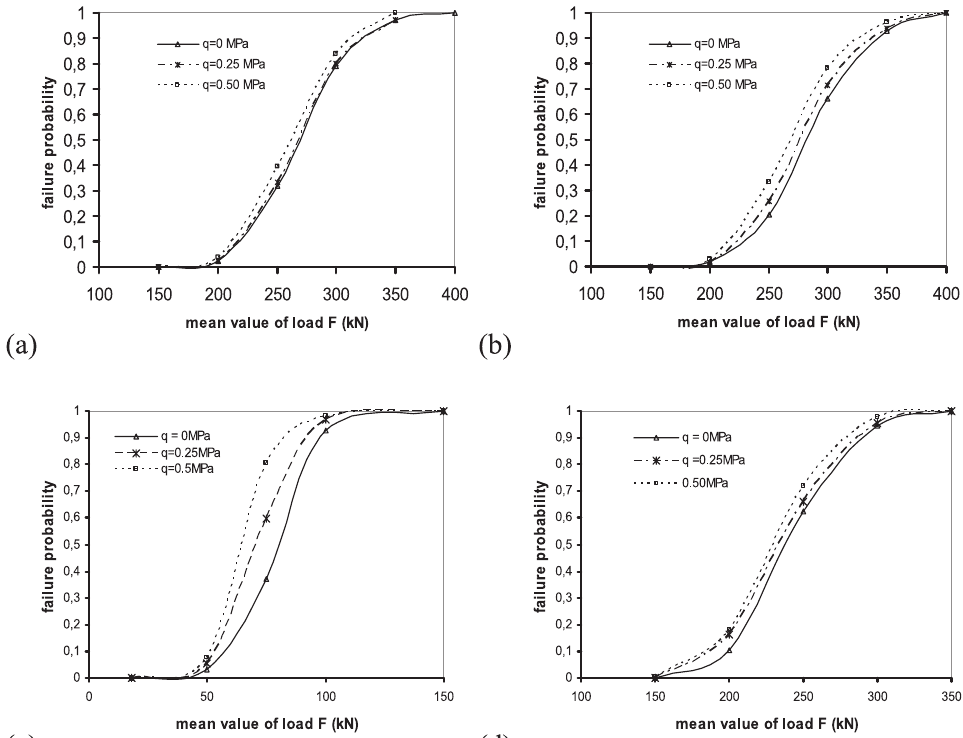
Fig. 9. Failure probability according to loads F and q : (a) steel, (b) carbon-epoxy, (c) glass-epoxy, (d)